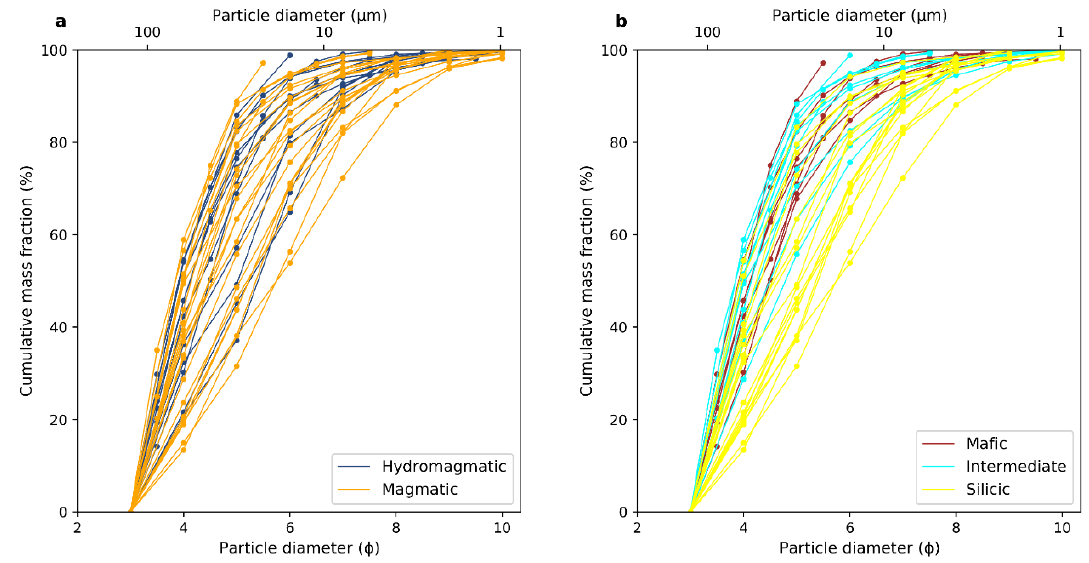
Figure 3. The < 125 µ m fraction of total grain size distributions based on deposits for all eruptions from Figures 1 and 2 (i.e., normalized to 125 µ m), highlighting ( a ) hydromagmatic vs. magmatic eruptions, ( b ) mafic ( ≤ 52% SiO 2 ) vs. intermediate (52–63% SiO 2 ) vs. silicic ( > 63% SiO 2 ) eruptions.